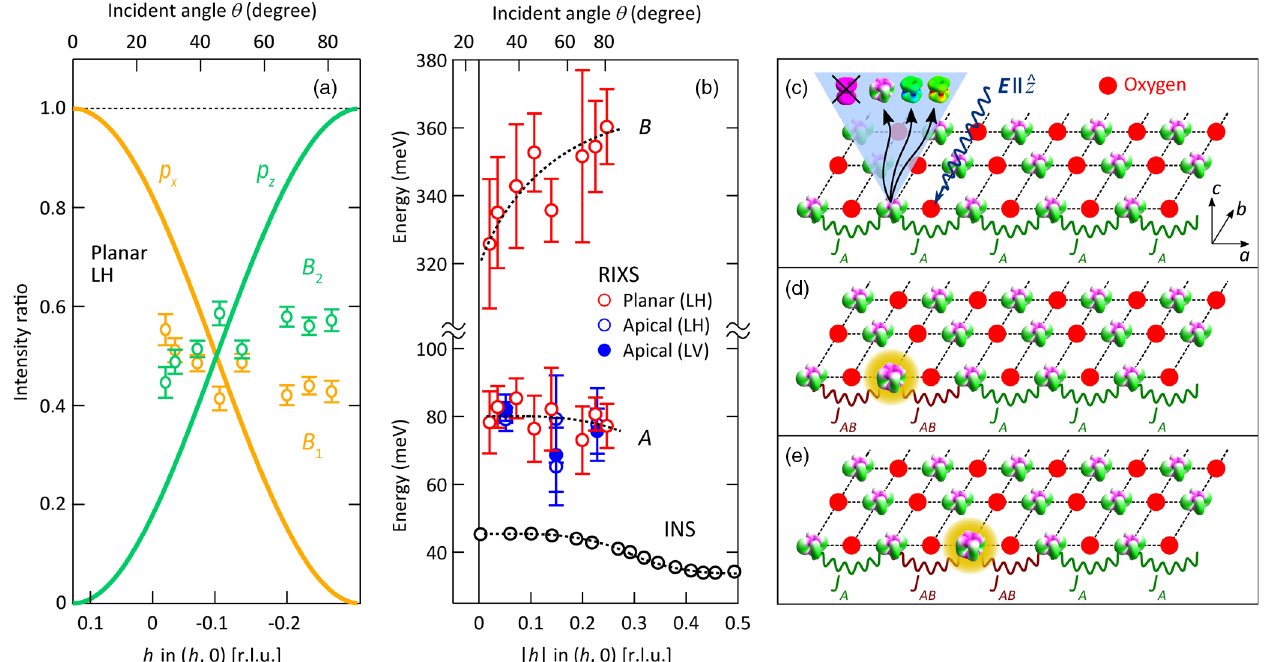
FIG. 5. Momentum-dependent analysis of the low-energy excitations. (a) Peak amplitudes of the assumed B 1 (yellow) and B 2 (green) modes extracted from fits (with fixed peak widths and positions — see text) as shown in Fig. 4(a). Corresponding solid cosine squared lines indicate, for LH, the expected coupling to the p and p oxygen orbitals. (b) Extracted dispersion along the Q ¼ ð h; 0 Þ direction of x z the A and B excitations in meV, as shown before in panel (a) of Fig. 4. The dispersion is defined by the peak maxima, which in the case of the B excitation, is derived from a derivative of the spectra. Error bars indicate standard deviations 3 σ and σ for the A and B , respectively. Comparison to the spin excitation branch observed by neutron scattering (reproduced from Ref. [7]) along the same direction is also shown in panel (b). Dashed lines are guides to the eye. (c) Schematic of an oxygen K -edge RIXS process creating a local excitation between the α and β sectors (see Fig. 4). Panels (d) and (e) illustrate propagation of the spin-orbital excitation. The nearest-neighbor couplings are denoted J between sites in the α sector and J between α and β A AB